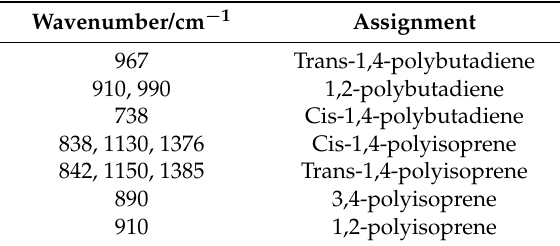
Table 3. The wavenumber and corresponding peak assignment of the resulting copolymers obtained from the IR spectra.